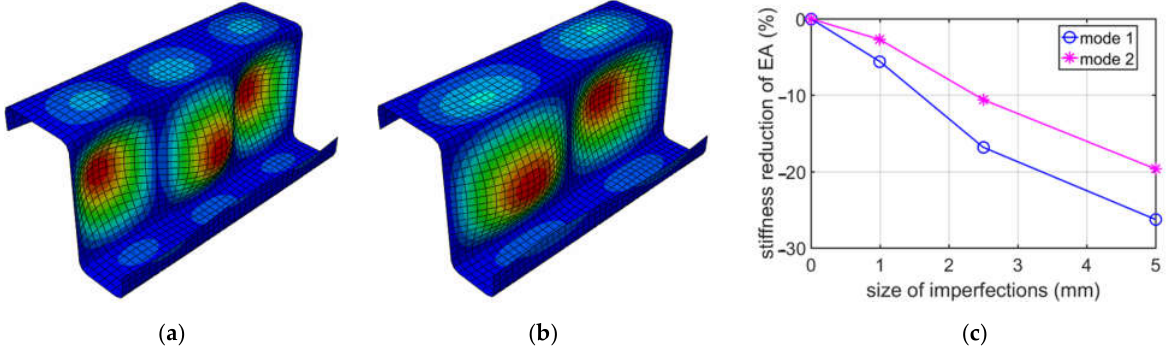
Figure 5. Buckling in compression for 150 mm depth: ( a ) mode 1; ( b ) mode 2; ( c ) plot of the stiff- ness reduction of  , depending on the size of imperfections.